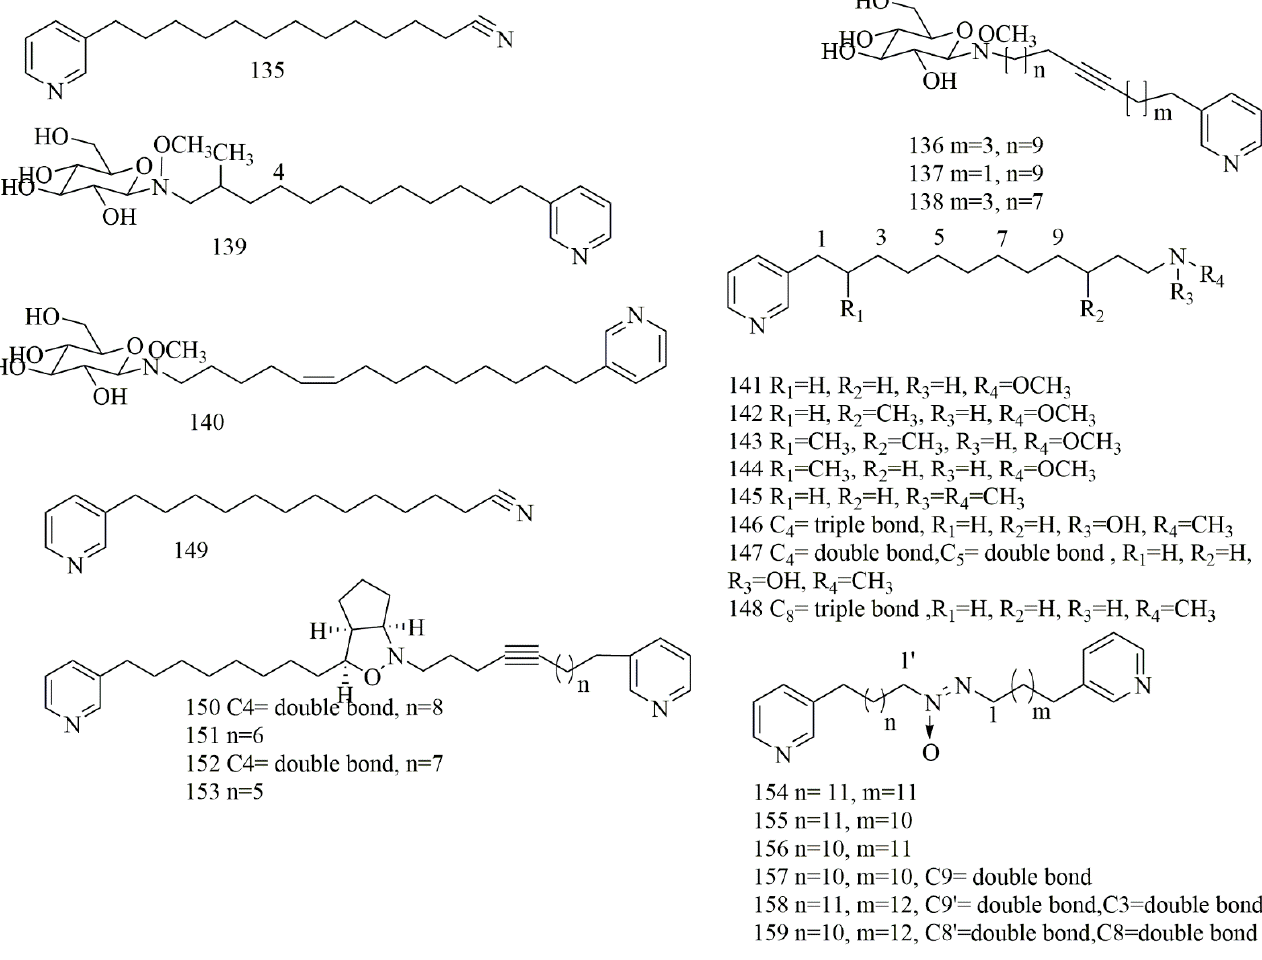
Figure 12. Pyridine alkaloids from sponges.